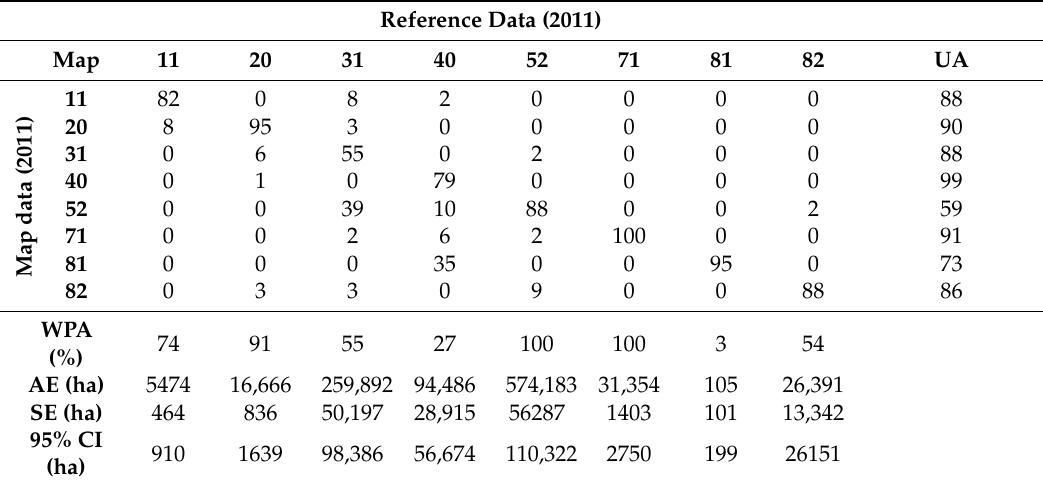
Table A8. Error matrix of Eddy county (2011) expressed by Area Weighted Proportions (%).